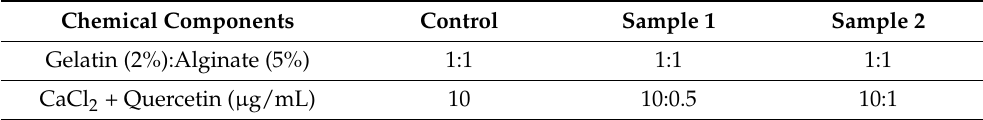
Table 1. Chemical composition of drug-loaded scaffolds with different concentrations. Chemical Components Control Sample